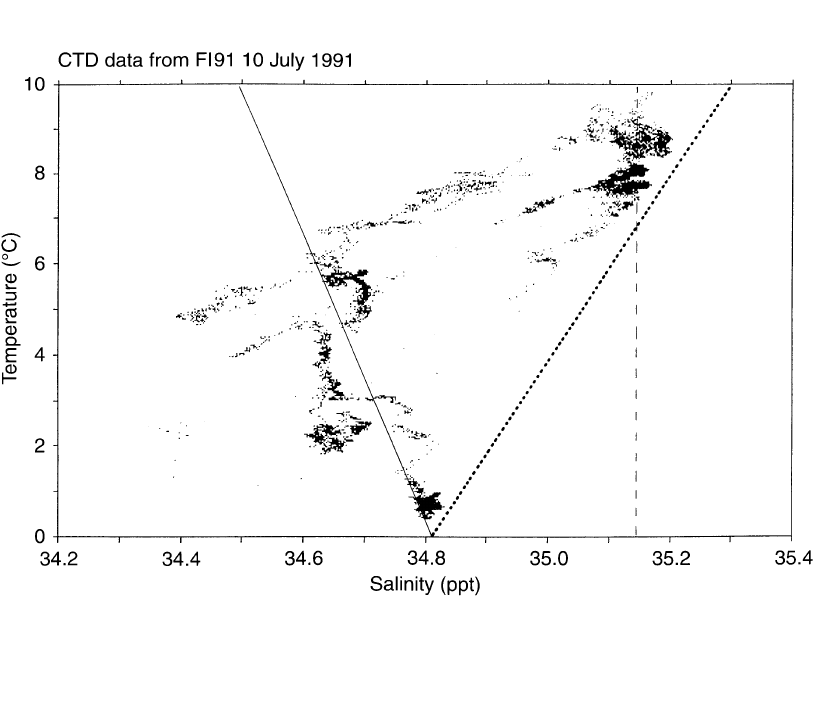
Fig. 5a, b. Feature models of the features shown in Fig. 3: a the cold eddy; b the western end of the Iceland-Faeroes front. The temperature scale in ° C is shown on the colour - bars